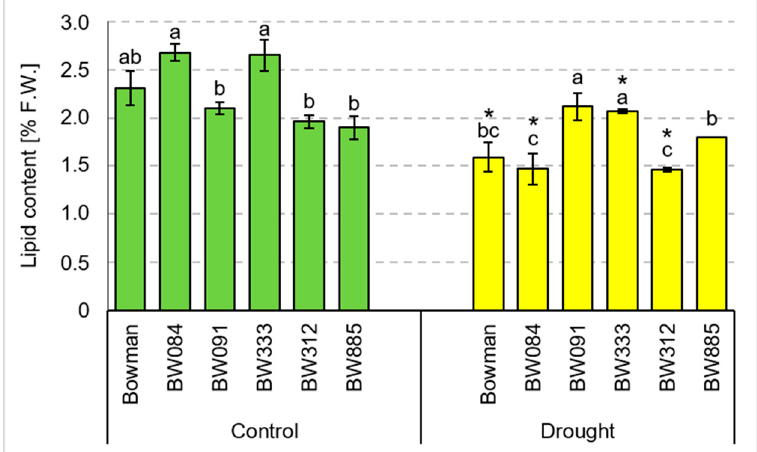
Figure 12. Total lipid contents in grains of the analyzed genotypes under the optimal watering (control) conditions and after the drought stress (the pot experiment). The mean values ± (SD) marked with the same letters (separately for the control and drought-stressed plants) are not significantly different, according to Duncan’s test ( p ≤ 0.05). Asterisks denote significant difference in comparison of values reported in each genotype between the control and drought conditions according to Student’s t -test. Details are given in the text.